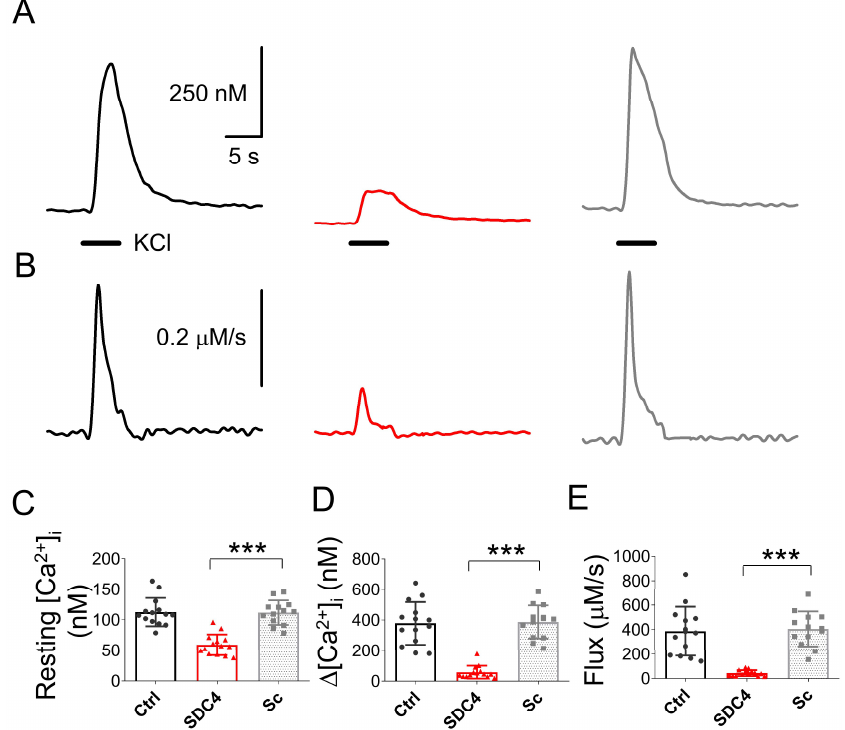
Figure 5. Representative KCl depolarization-evoked Ca 2+ transients measured on 5-day-old differen- tiated control (Ctrl, black), Syndecan-4-downregulated (KD, red), and scrambled (Sc, grey) C2C12 myotubes ( A ). ( B ) Calcium release from the SR, calculated from the traces in panel A. ( C ) Pooled data for resting [Ca 2+ ] i . ( D ) The maximal increase in [Ca 2+ ] i upon KCl depolarization. ( E ) Peak calcium flux release from the SR. The protocol of the solution exchange in panel A was 5 s long 120mM KCl in normal Tyrode’s solution (black horizontal solid lines also show the level of zero). The number of cells averaged was 14, 14, and 13 from 3 independent control (Ctrl), Syndecan-4-KD (KD), and scrambled (Sc) cell cultures, respectively. *** denotes a significant difference from the scrambled group at p < 0.001.